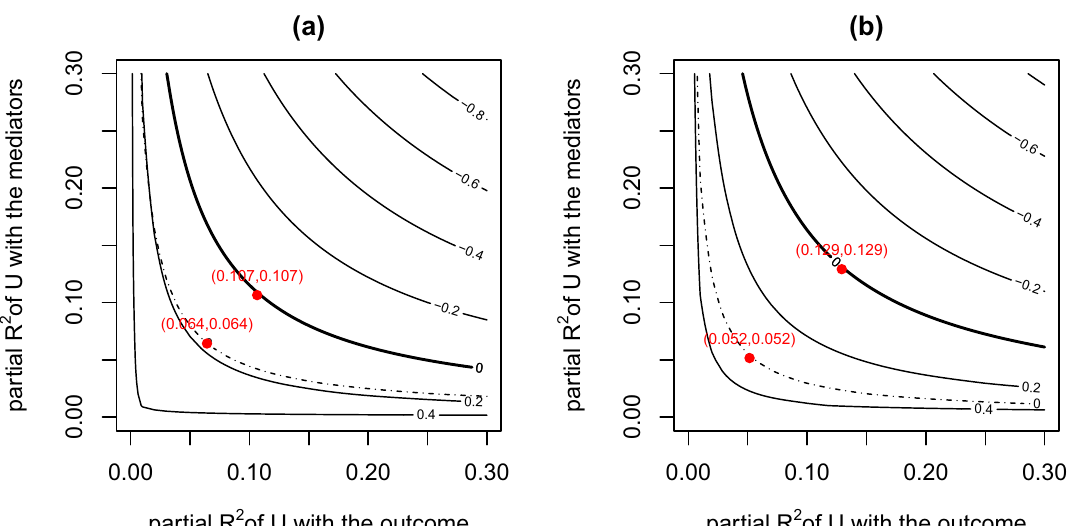
Figure 3: Sensitivity contour plots using R 2 values. ( a ) Disparity reduction. ( b ) Disparity remaining. Note ( 1 ) Bold lines represent the points at which the estimates become zero. ( 2 ) Standard lines represent the points at which the estimates become the respective value ( e.g., −0.2, −0.1, 0.1, 0.2 ) . ( 3 ) Dashed lines represent the points at which the upper and lower CIs include zero. ( 4 ) Red points represents the RVs, i.e., the partial R 2 values that make the estimates or upper/lower limits of CIs zero, assuming equal R 2 values between the two sensitivity